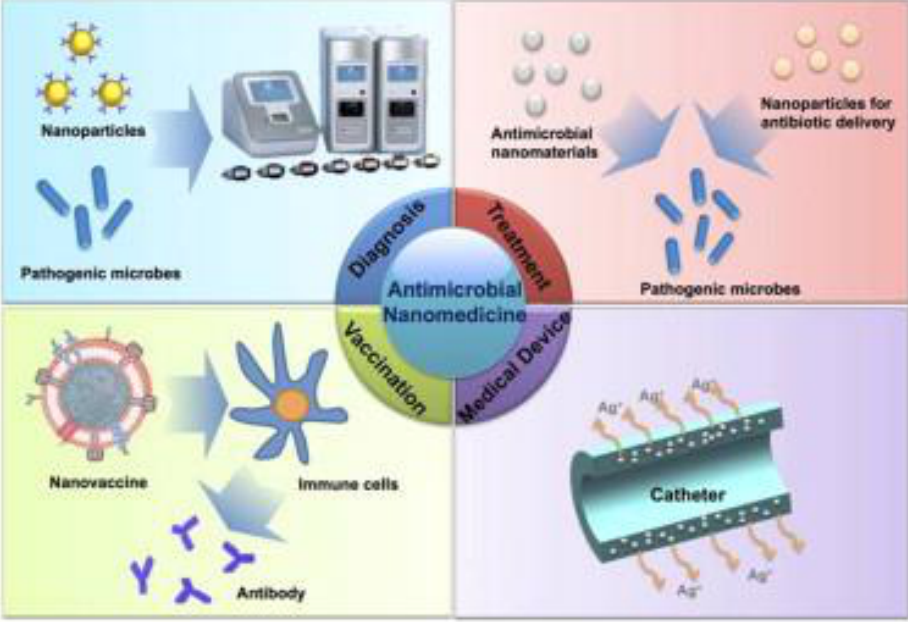
Figure 1. Applications of nanomedicine in the treatment of infectious diseases caused by microbes. Reproduced with permission from [24]. Copyright Elsevier, 2014.